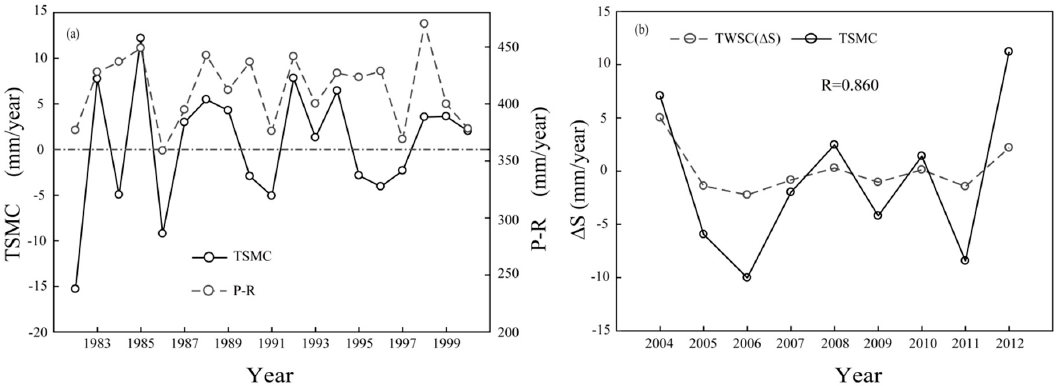
Figure 4. ( a ) The time series of annual soil moisture changes (TSMC) and the differences in precipitation and runoff (P–R) for the Yellow River Basin during 1982–2000, and ( b ) the comparison between the terrestrial water storage changes ( Δ S) estimated by the Gravity Recovery and Climate Experiment (GRACE) and the annual soil moisture changes (TSMC) during 2004–2012.